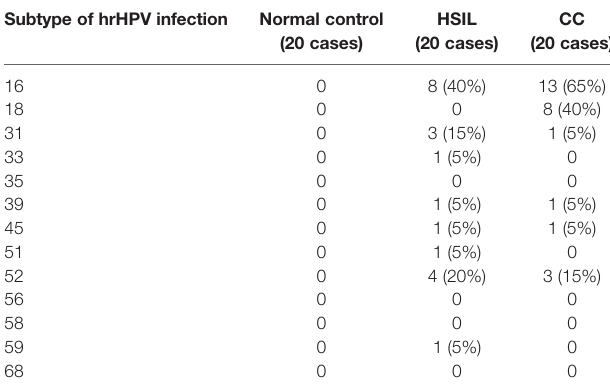
TABLE 2 | Subtype distribution of high-risk HPV infection in different cervical lesions